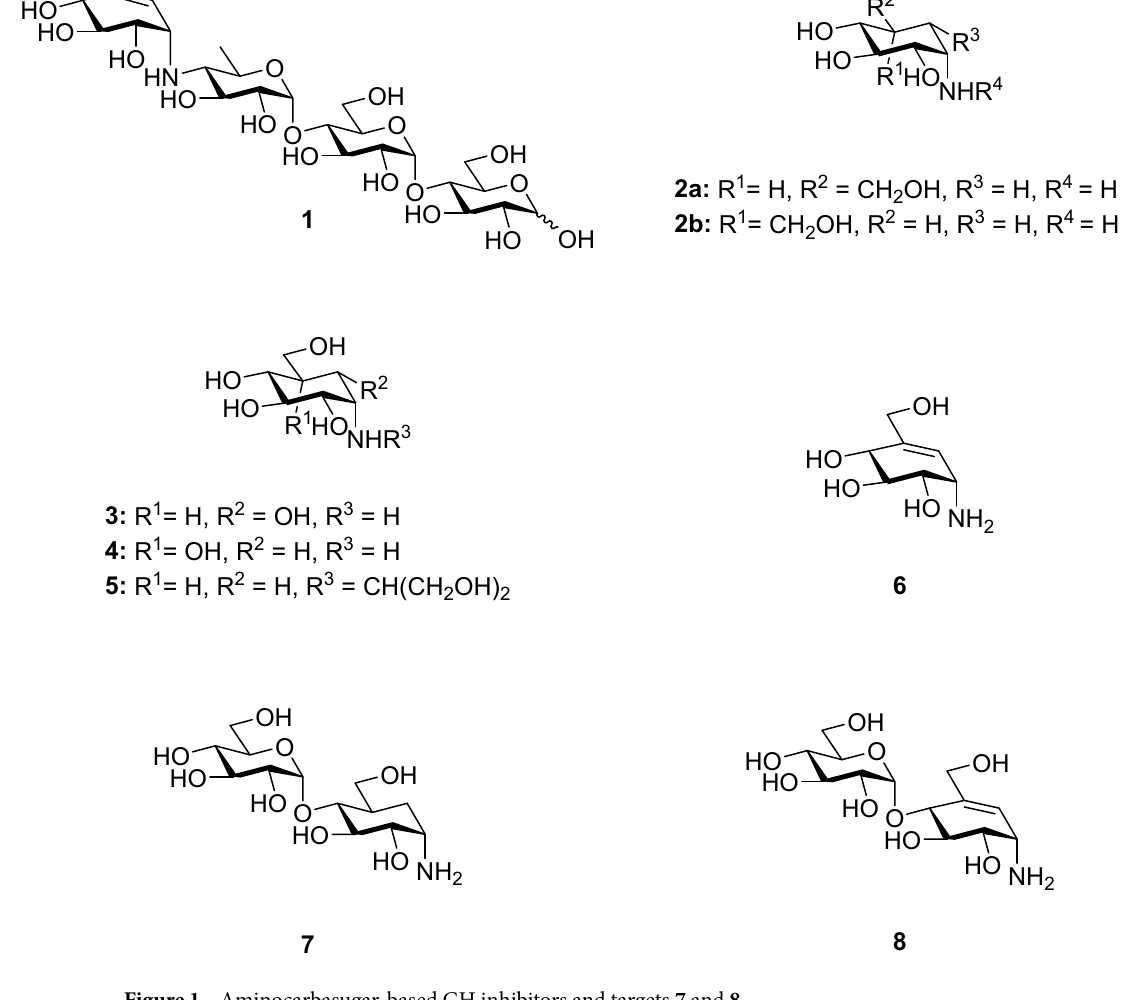
Figure 1. Aminocarbasugar-based GH inhibitors and targets 7 and 8